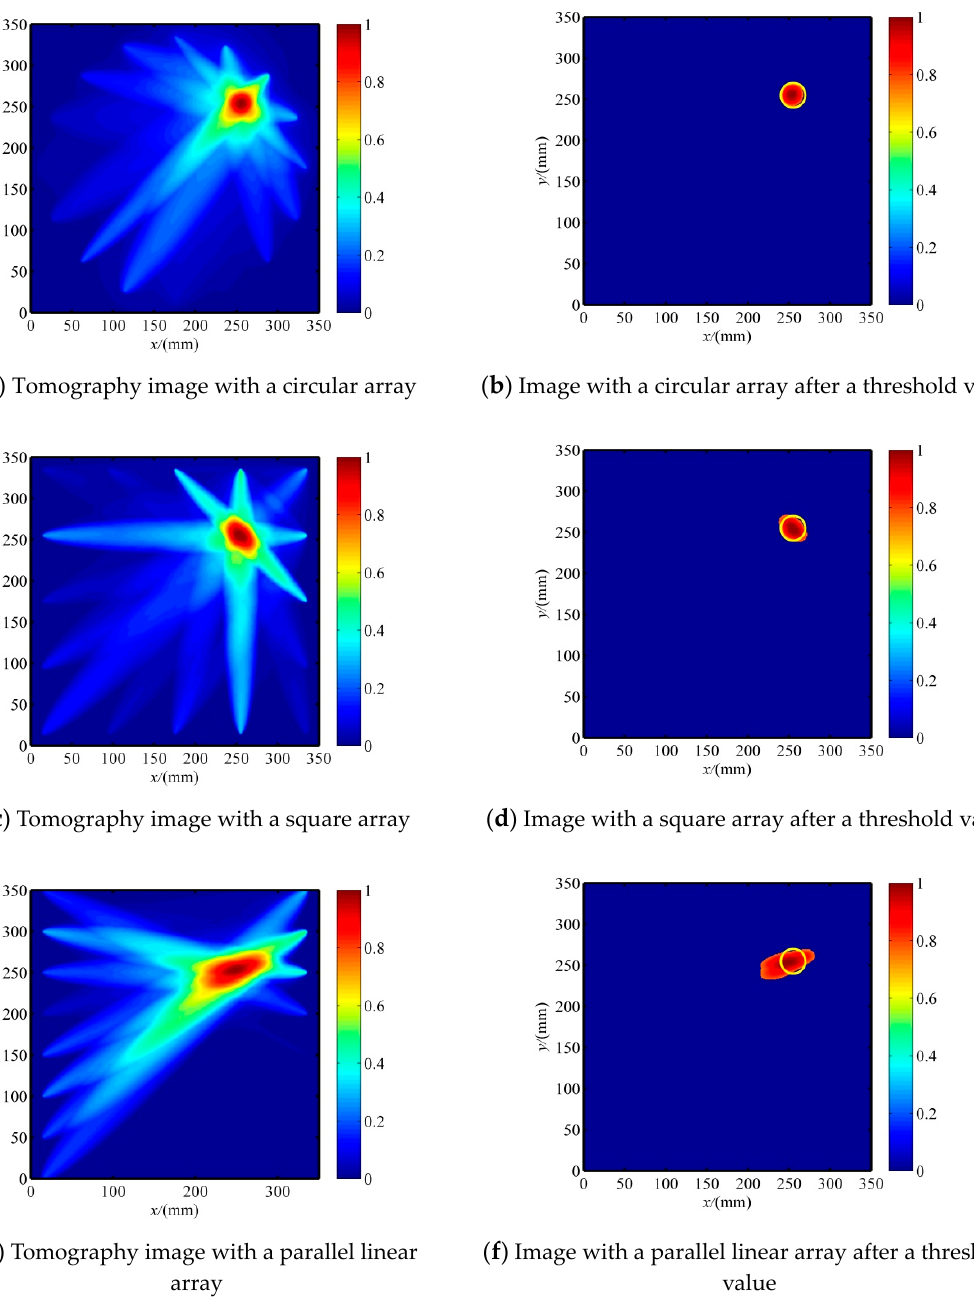
Figure 6. Comparison of the tomography images with three PZT sensor array configurations for a specimen with a hole. Table 1. The resultant imaging accuracy of a hole with three PZT sensor array configurations.